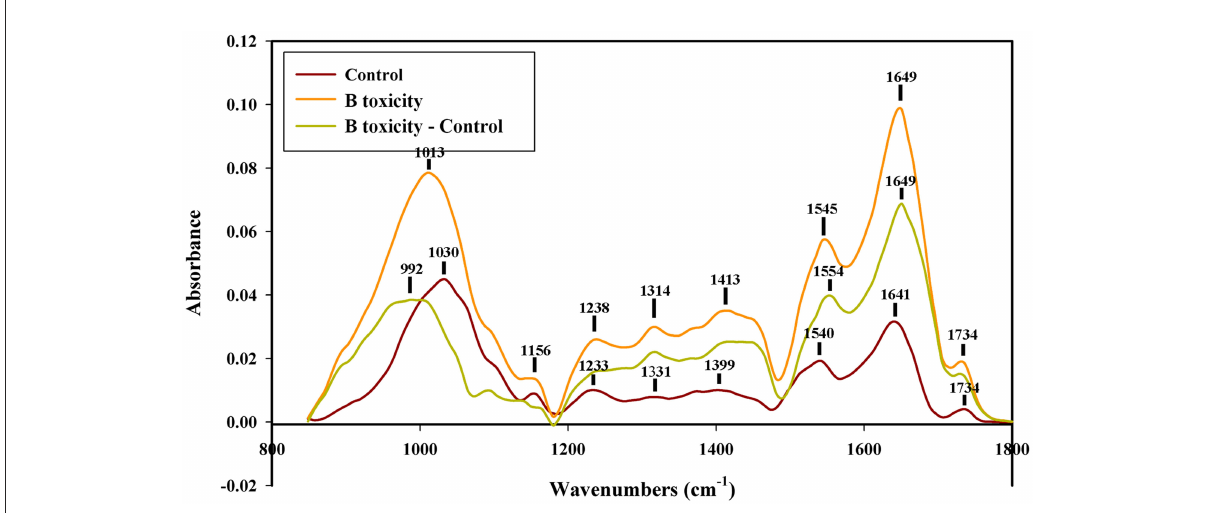
FIGURE5 FTIR spectra from the tip regions of C . mollissima pollen tubes (control pollen tube: Control), B toxicity-treated pollen tubes and the FTIR differential spectrum (B toxicity – control) generated by digital subtraction of the control spectra from B toxicity-treated pollen tube